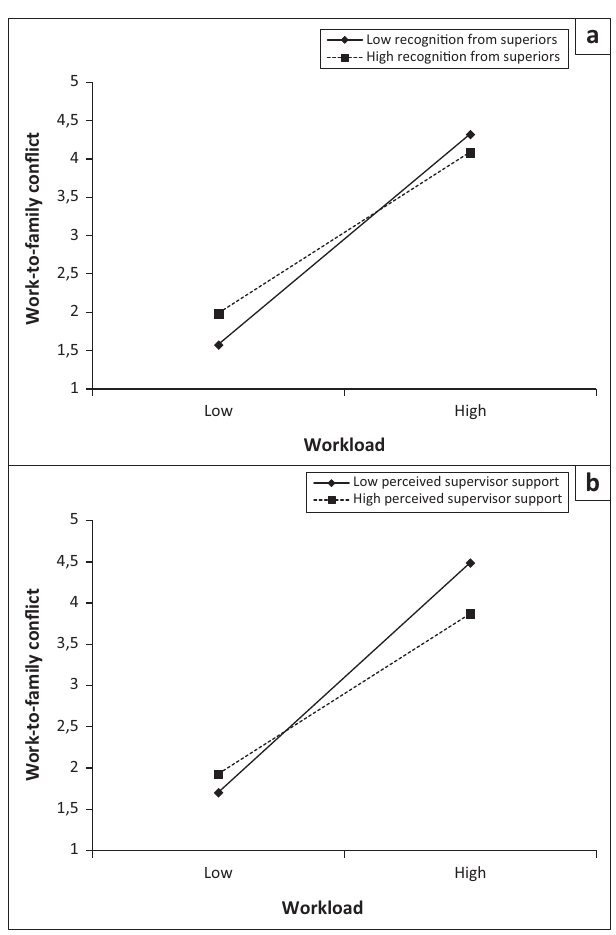
FIGURE 3: Graphical representations of the moderating role of recognition from supervisors: (a) and perceived supervisors support; (b) in the relationship between workload and work-to-family conflict.